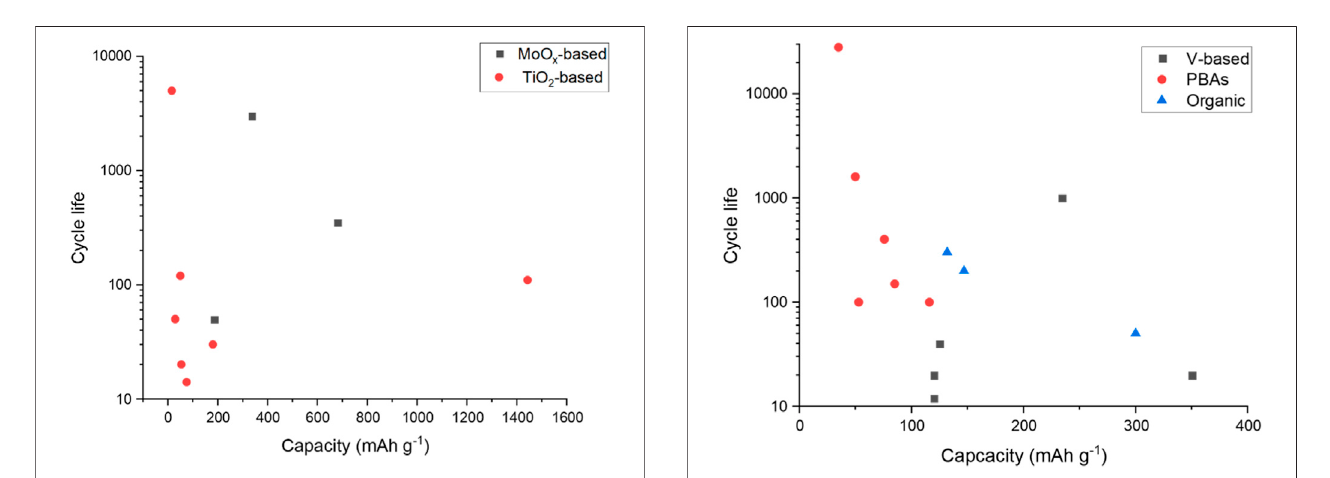
FIGURE 6 | Cycle life plotted against the speci fi c capacity for half-cell positive electrodes (González et al., 2016; Holland et al., 2018; Parvizi and Kazazi,2018;Nacimientoetal.,2018;Zhouetal.,2019;Josephetal.,2019a; Lahan and Das, 2019a; Lahan and Das, 2019b; Kumar et al., 2019; Mohanapriya and Jha, 2019; Ru et al., 2020; Cai et al.,